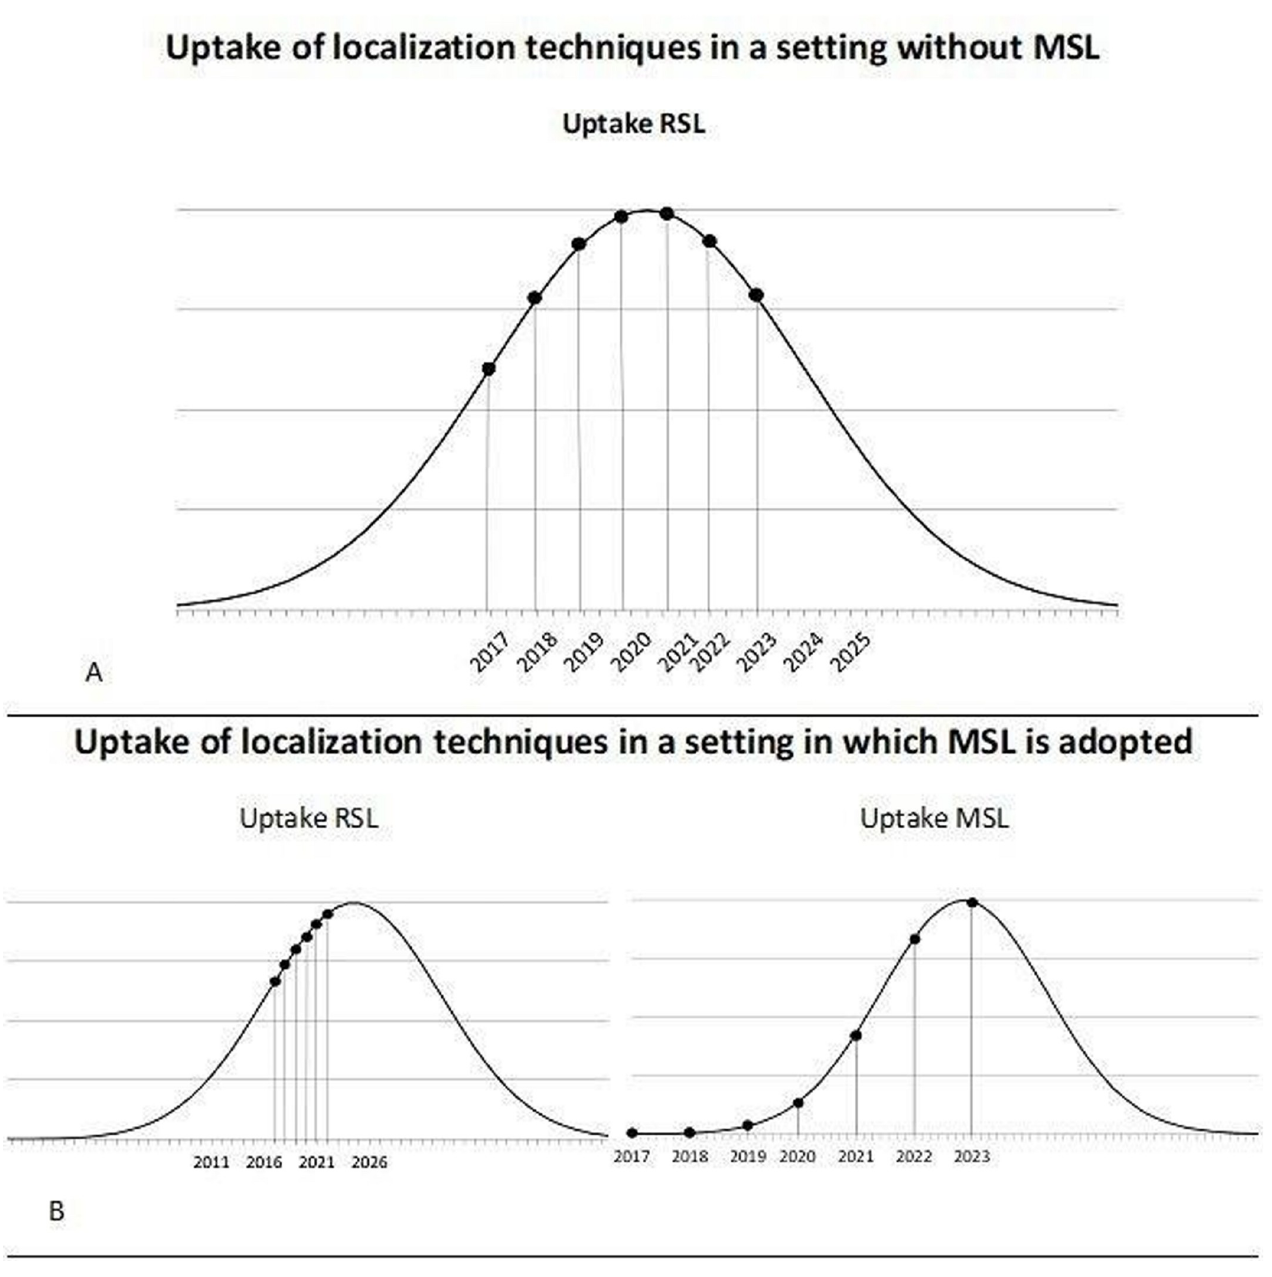
Fig 2. The expected uptake of RSL and MSL for both Standard of Care (SoC) and SoC with the adoption of MSL. (A) Shows the uptake of RSL when MSL is not implemented based on the adoption curve of Rogers and the assumed uptake of localization techniques in 2022: 70% RSL, 30% WGL. (B) Shows the uptake curves for RSL and MSL based on the adoption curve of Rogers and the assumed uptake of localization techniques in 2022: 30% MSL, 40% RSL. These curves were used to identify the number of patients per year receiving one of the technologies and to identify the hospitals that transfer from one technology to another. Abbreviations: WGL = wire-guided localization, RSL = radioactive seed localization, MSL = magnetic seed